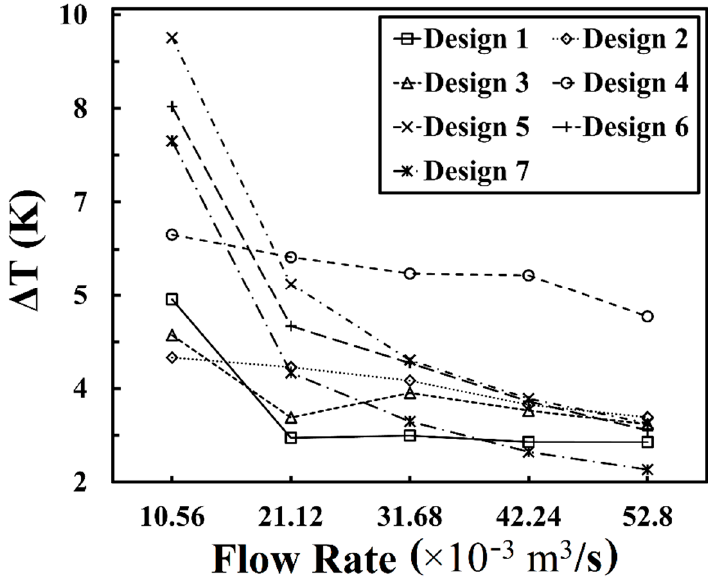
Figure 8. Temperature differences of 7 designs at 5 flow rates.